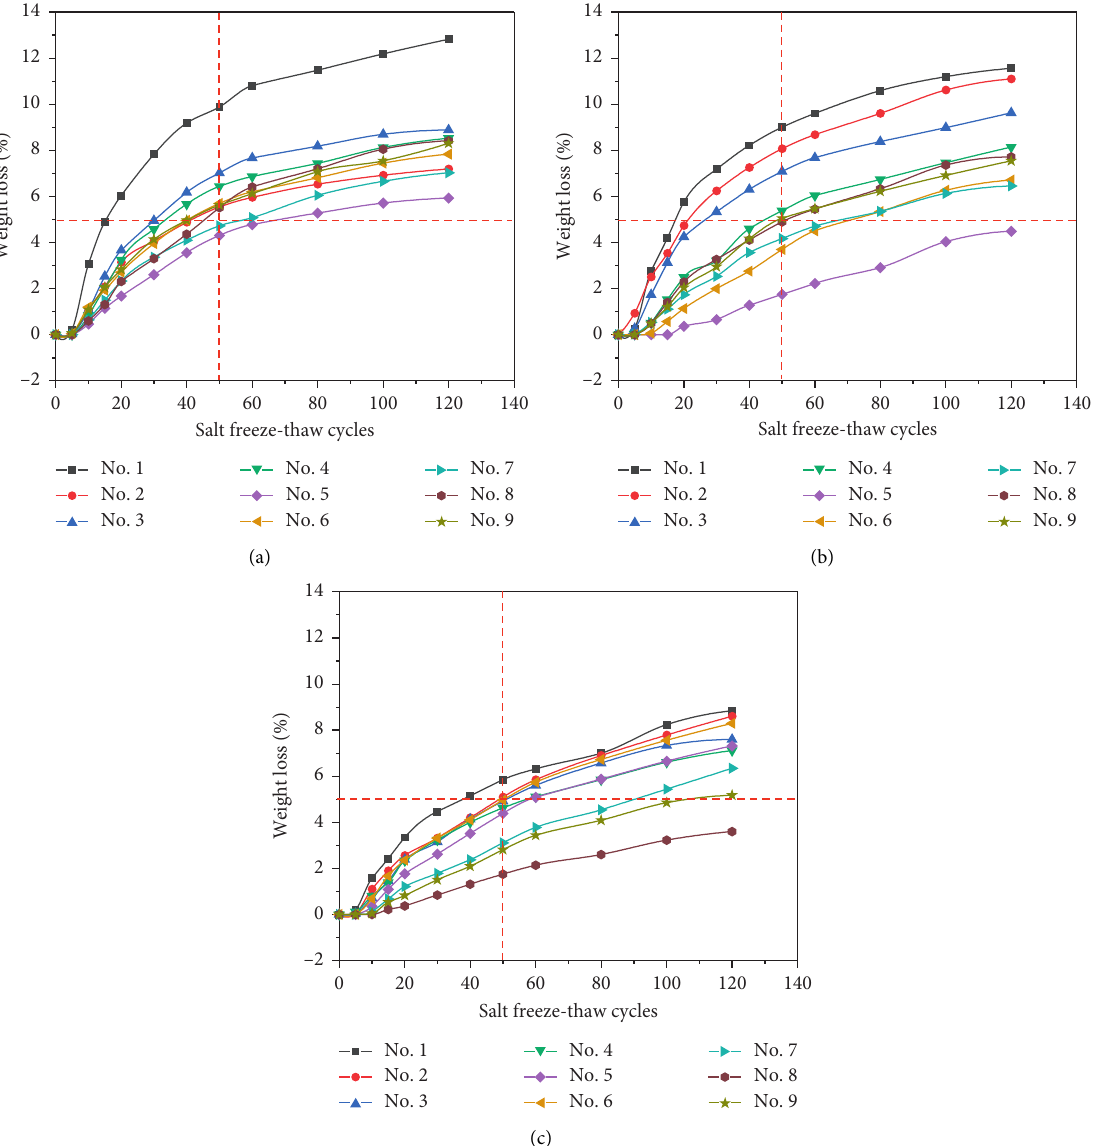
Figure 9: Weight loss of concrete with triple-admixtures versus salt freeze-thaw cycles. (a) Air content of (2.5 ± 0.5)%. (b) Air content of (4.5 ± 0.5)%. (c) Air content of (6.5 ±